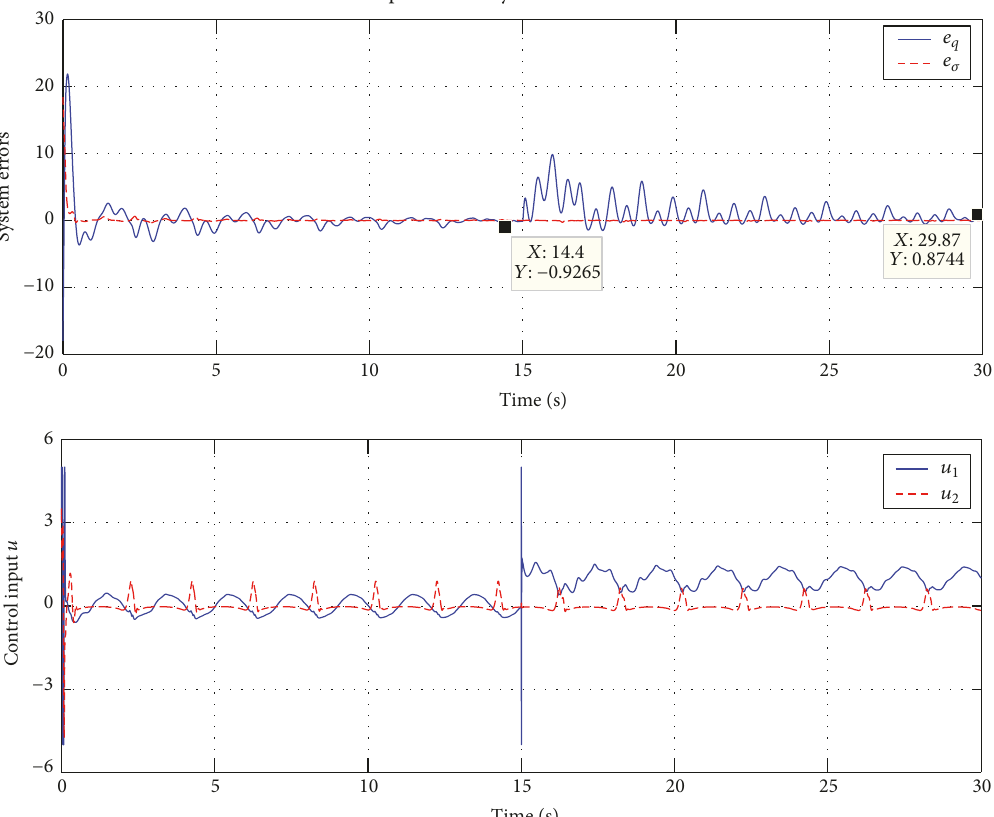
Figure 6: Control trajectories by the proposed NNAC with